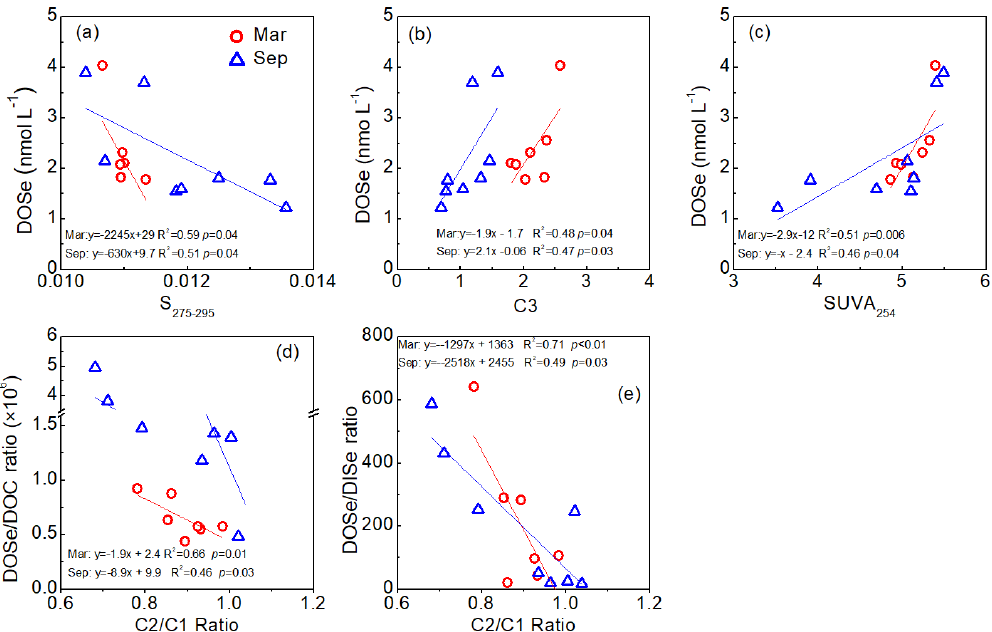
Figure 5. Relationships between DOSe concentrations and S 275–295 , C3 components and SUVA 254 , DOSe / DOC ratio and C2 / C1 com- ponent ratios, and DOSe / DISe ratios and C2 / C1 component ratios in the Rajang and Maludam estuaries. The S 275–295 , SUVA 254 , C1, C2 and C3 components are from Martin et al. (2018) and Zhou et al. (2019) taken during the same